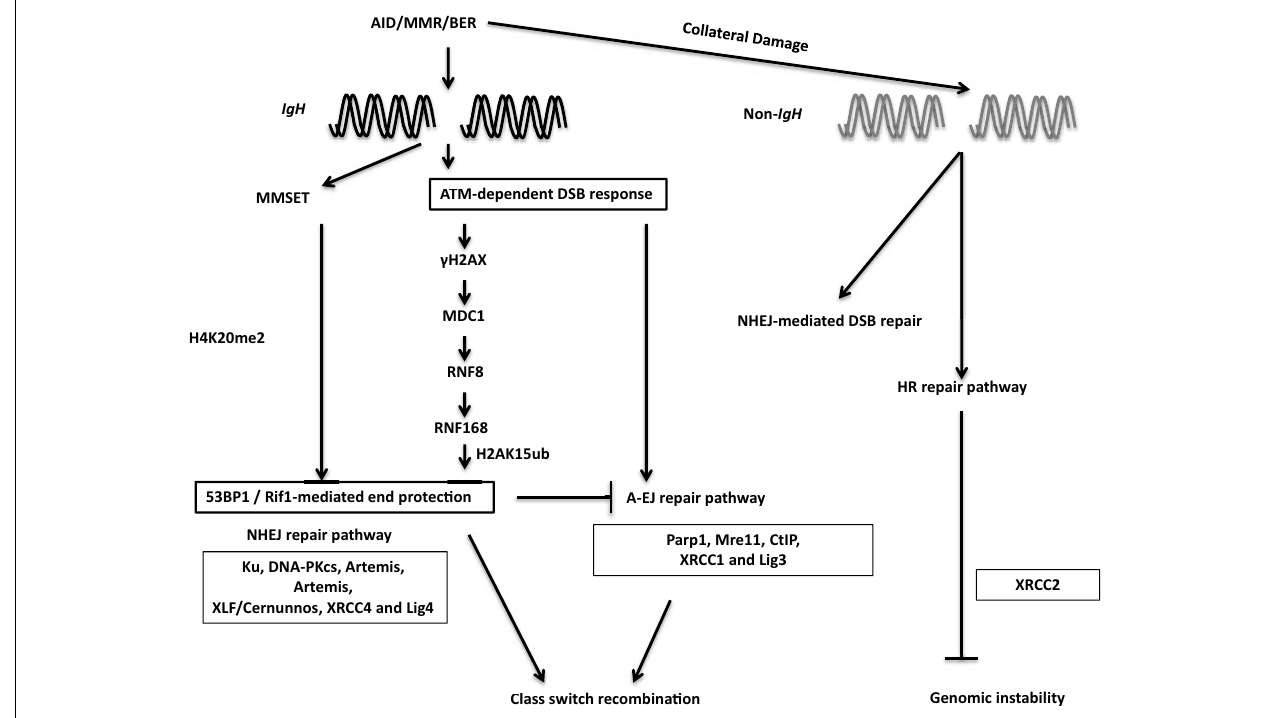
through the γ H2AX–RNF8–RNF168 node (see text for details). 53BP1-dependent end protection facilitates ligation of two S regions by NHEJ and/or A-EJ. Collateral damage induced by AID at non-Ig genes is repaired by NHEJ and by XRCC2-dependent homologous